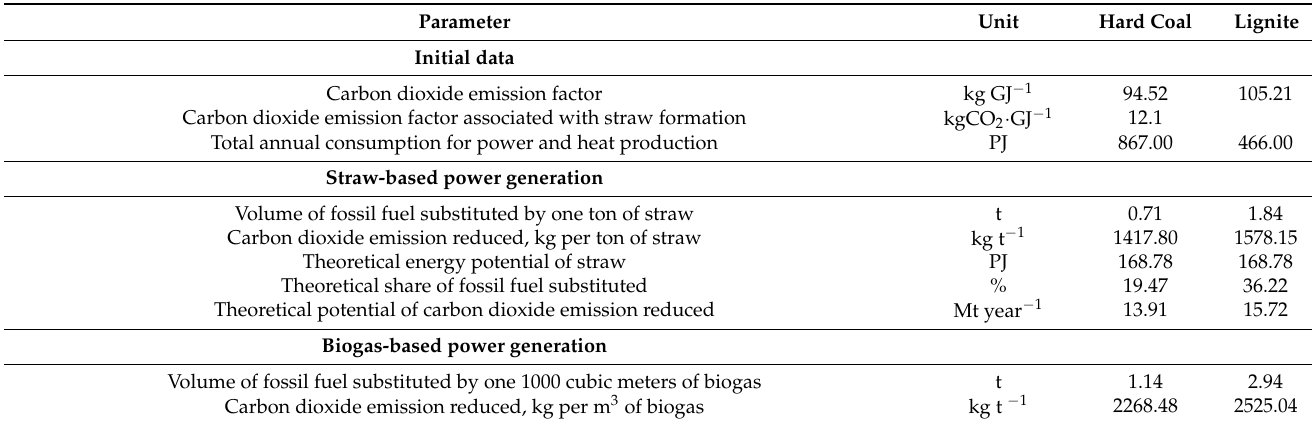
Table 3. A decrease in carbon dioxide